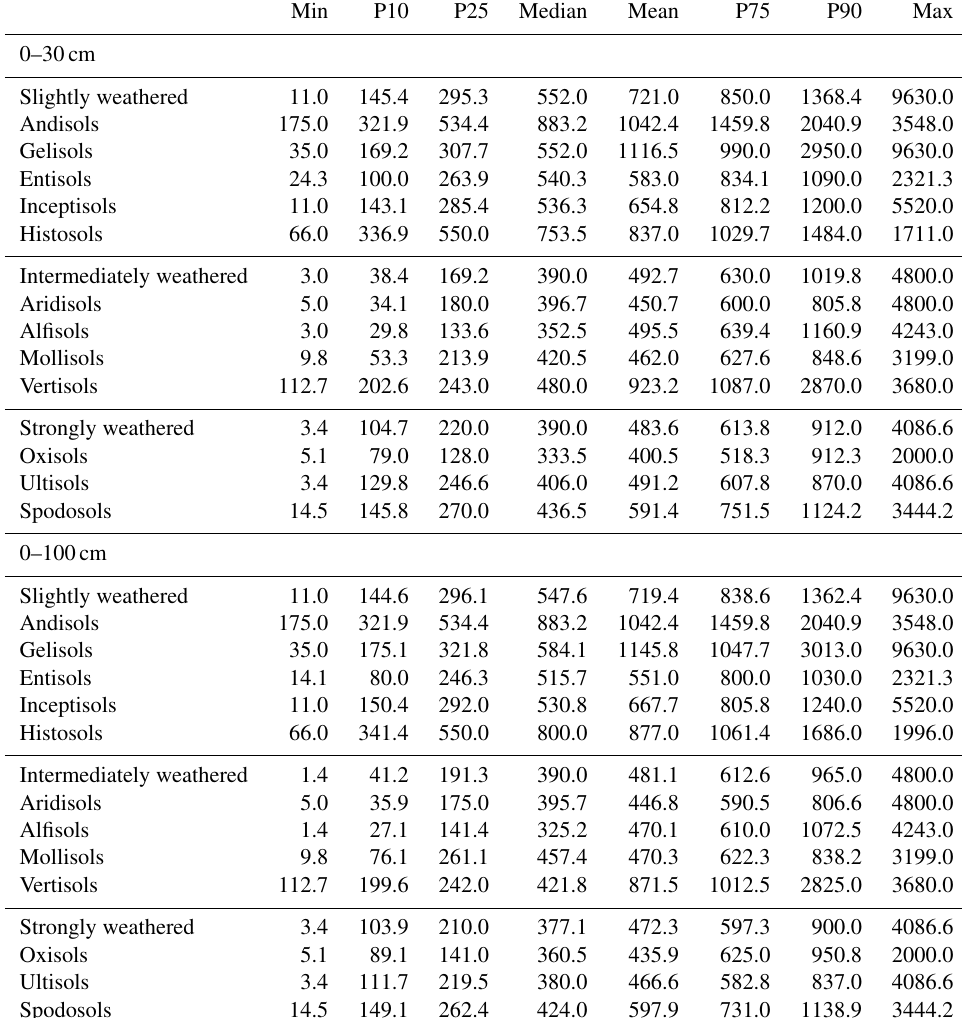
Table 3. Soil total P concentration (mgkg − 1 ) in 12 USDA soil orders and three weathering stages at 0–30 and 0–100cm depth. Results are based on our database. P10, P25, P75, and P90 indicate the percentile ranks of 10%, 25%, 75%, and